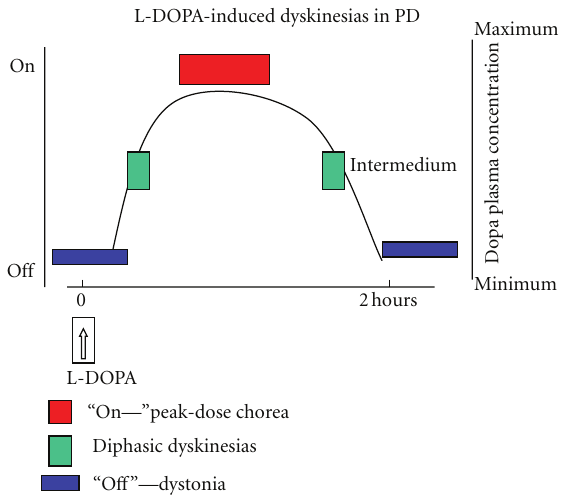
Figure 1: Relationship between LID and DOPA plasma level. “Peak of dose” or “on” period dyskinesia is correlated to high level of levodopa and in parallel with the maximal clinical benefit. Diphasic dyskinesia appears at the onset and o ff set of the levodopa e ff ect in relationship with increment or decrement of plasma level. “O ff ” period dystonia is characterized by painful postures in lower extremities and is correlated with the lowest levodopa level. Generally a full spectrum of the three types is present in patients with motor